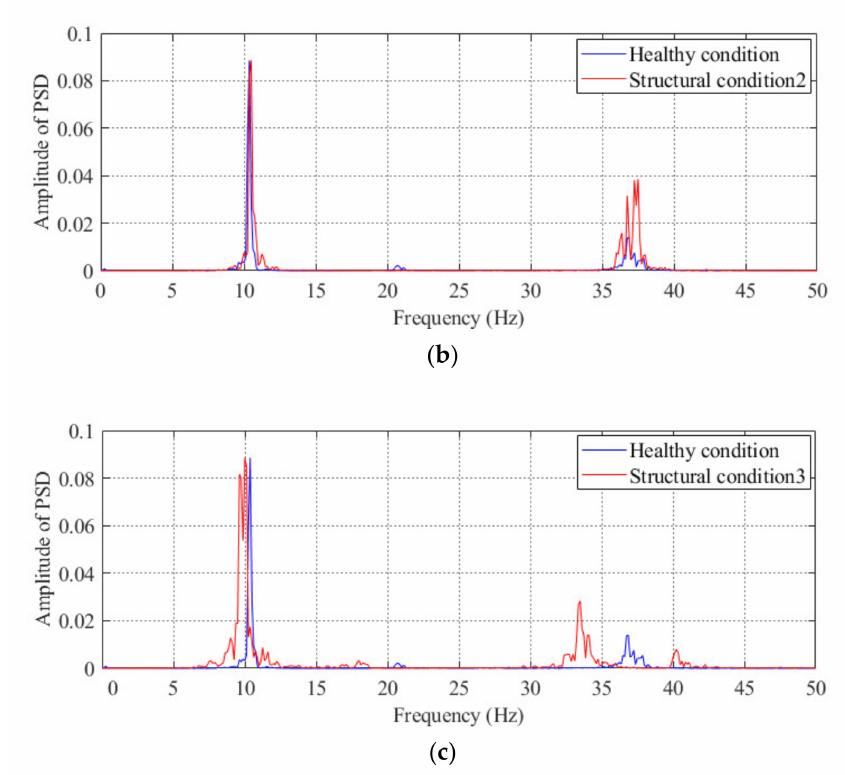
Figure 7. Auto-PSD obtained by using the acceleration response of sensor #3 under di ff erent structural conditions of the model bridge: comparisons between the healthy condition and ( a ) structural condition 1; ( b ) structural condition 2, and ( c ) structural condition 3.